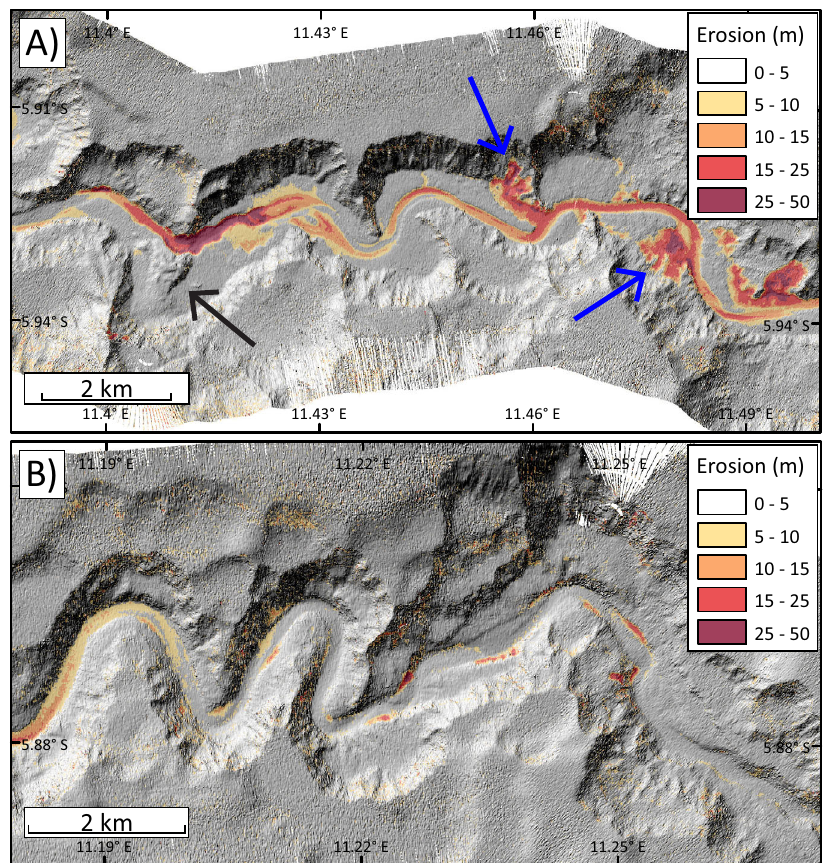
Fig. 6 Changes in seabed elevation, and patterns of localised seabed erosion, along two sections of the upper Congo Canyon between September – October 2019 and October 2020. Depth of erosion is shown in red, with (hillshaded) bathymetry from 2019 shown underneath in grey-scale. A Location where deep erosion in 2019 – 2020 is associated with knickpoints (steeper zones in canyon long-pro fi le), between moorings M4 and A2/M1 (see Fig. 1b for mooring locations). Note also the prominent canyon side-wall failures in 2019 – 2020 (blue arrows), and an older (pre-2019) landslide-dam (black arrow) that created a major knickpoint 64 . B Location between moorings A3 and M2/9 (Fig. 1b) where turbidity currents in 2019 – 2020 caused much less erosion of the canyon fl oor. Also see Supplementary Figs. 7 and 8 for additional maps showing patterns and magnitudes of sea fl oor